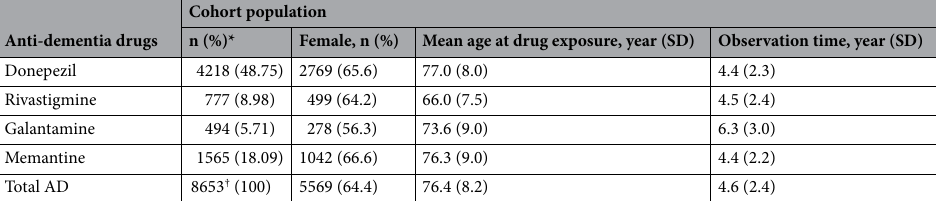
Table 2. Demographic of cohort population. n indicates the number of subjects. *Percent values indicate the number of anti-dementia medications over total number of firstly diagnosed as Alzheimer’s dementia (AD). † Total number of AD subjects are not equal to the sum of each drug because there are AD patients without any medications such as N -methyl-d-aspartate (NMDA) receptor antagonist (e.g. Memantine) and cholinesterase inhibitors (AChEIs) (e.g. Donepezil, Rivastigmine and Galantamine). The anti-dementia drugs were prescribed